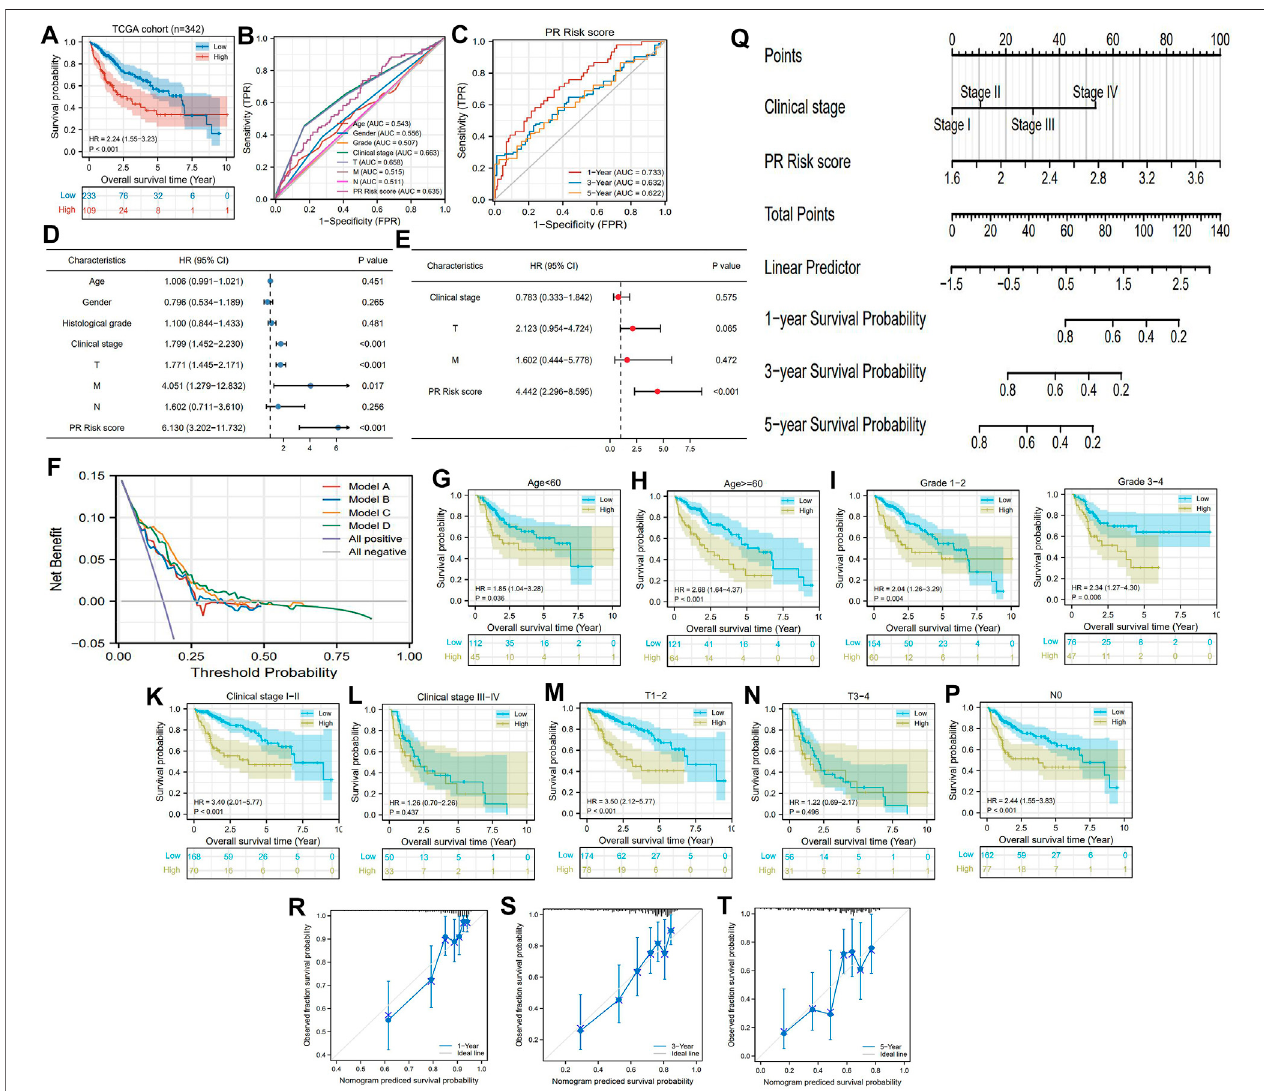
FIGURE 3 | Prognostic value of PR risk signature in HCC (A) The OS difference between high- and low-PR risk groups. (B) ROC curves of clinicopathologic features and PR risk score. (C) Time-dependent ROC curves of PR risk score. (D) The univariate independent prognostic analysis. (E) The multivariate independent prognostic analysis. (F) DCA results. “ Model A ” is the traditional prognostic model composed of age, histological grade, and clinical stage. “ Model B ” is the traditional prognostic model composed of age, histological grade, and TNM staging. “ Model C and D ” are the improved models A and B, respectively, with the PR risk score added. (G – P) The OS difference between high- and low-PR risk groups in each clinical subgroup (Q) The nomogram is used for predicting 1-, 3-, and 5-year overall survival probability of HCC patients (R – T) The calibration curves. PR, pyroptosis-related; HCC, hepatocellular carcinoma; OS, overall survival; ROC, receiver operating characteristic curve; DCA, decision curve analysis; HR, hazard